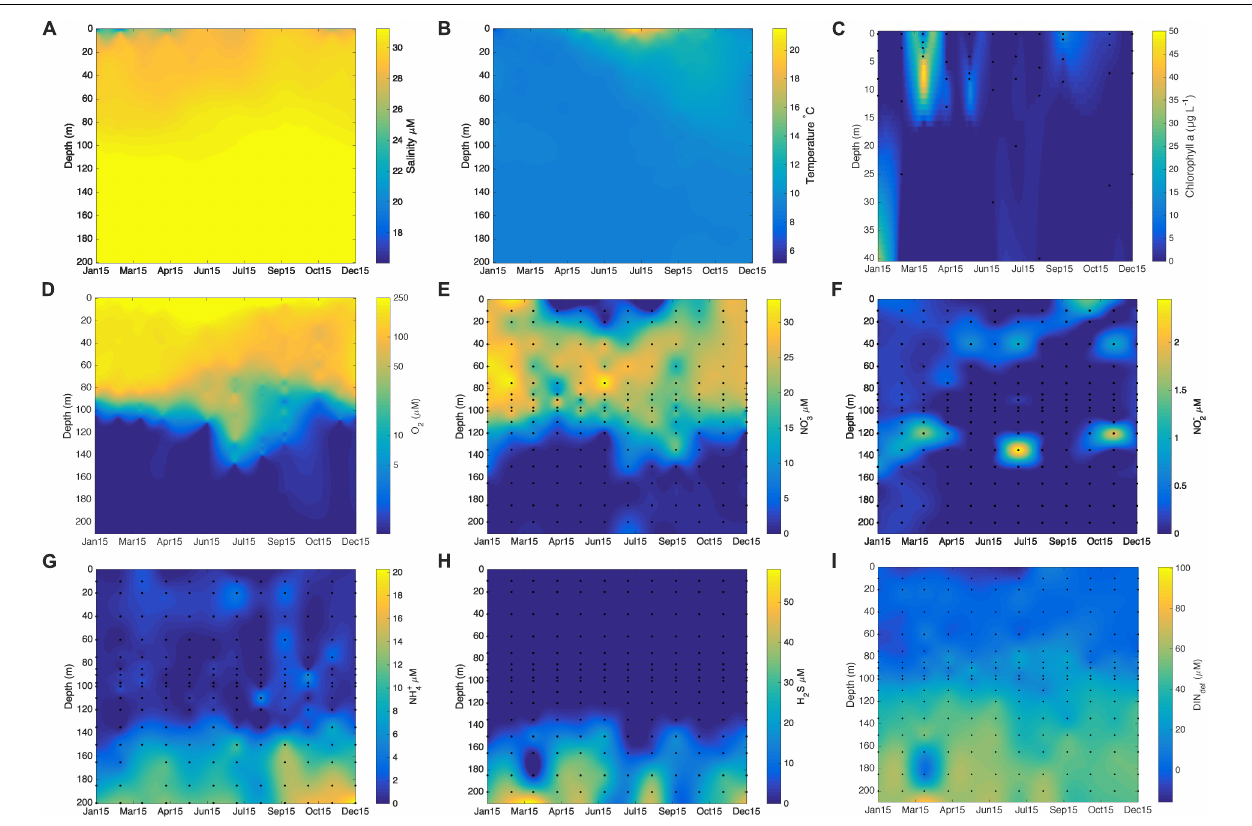
FIGURE 2 | (A) Salinity (g kg − 1 ); (B) temperature ( ◦ C); (C) chlorophyll a ( µ g L − 1 ); (D) oxygen profiles ( µ M); (E) NO 3 − concentrations ( µ M); (F) NO 2 − concentrations ( µ M); (G) NH 4 + concentrations ( µ M); (H) HS − concentrations ( µ M); (I) calculated DIN deficit values (see section “Materials and Methods” in main text) for Saanich Inlet during the year 2015 at station S3. (A,B,D) Values have been obtained from the CTD profiles monthly. Intermediate values have been interpolated in matlab using the gridfit function (specifically the nearest neighbor). (C–G) Values were obtained from discrete sampled depths as indicated by black dots on graphs and interpolated in matlab using the gridfit function (specifically the nearest neighbor). Note that figure (C) only goes down to 40 m depth as the values obtained for